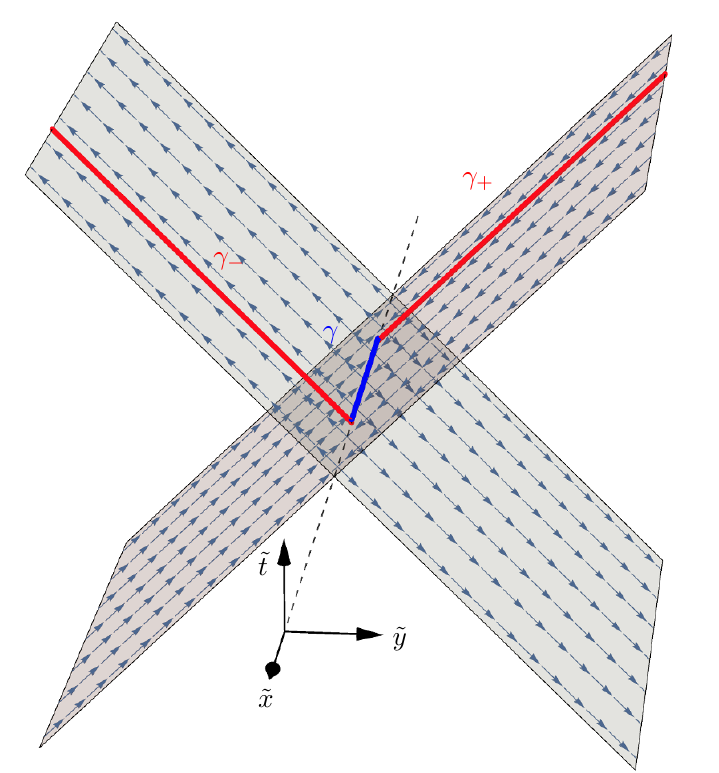
Figure 3 . Ryu-Takayanagi surface in coordinates (~ t; ~ x; ~ y ) in which the bulk modular (cid:13)ow is a boost. It is given by e A = (cid:13) (cid:0) [ (cid:13) [ (cid:13) + . The surface (cid:13) lies on the Rindler bifurcation surface (the dashed line) and the light rays (cid:13) + and (cid:13) (cid:0) are tangent to the modular